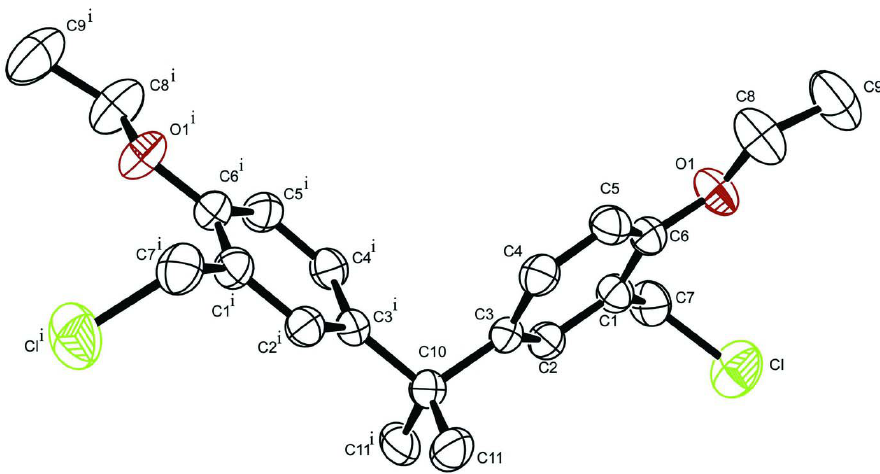
Figure 1 The molecular structure of BPAEtCl, showing the atom-labelling scheme. Displacement ellipsoids are drawn at the 50% probability level. H atoms have been omitted. Symmetry code: (i) - x + 1, y , - z + 5/2.